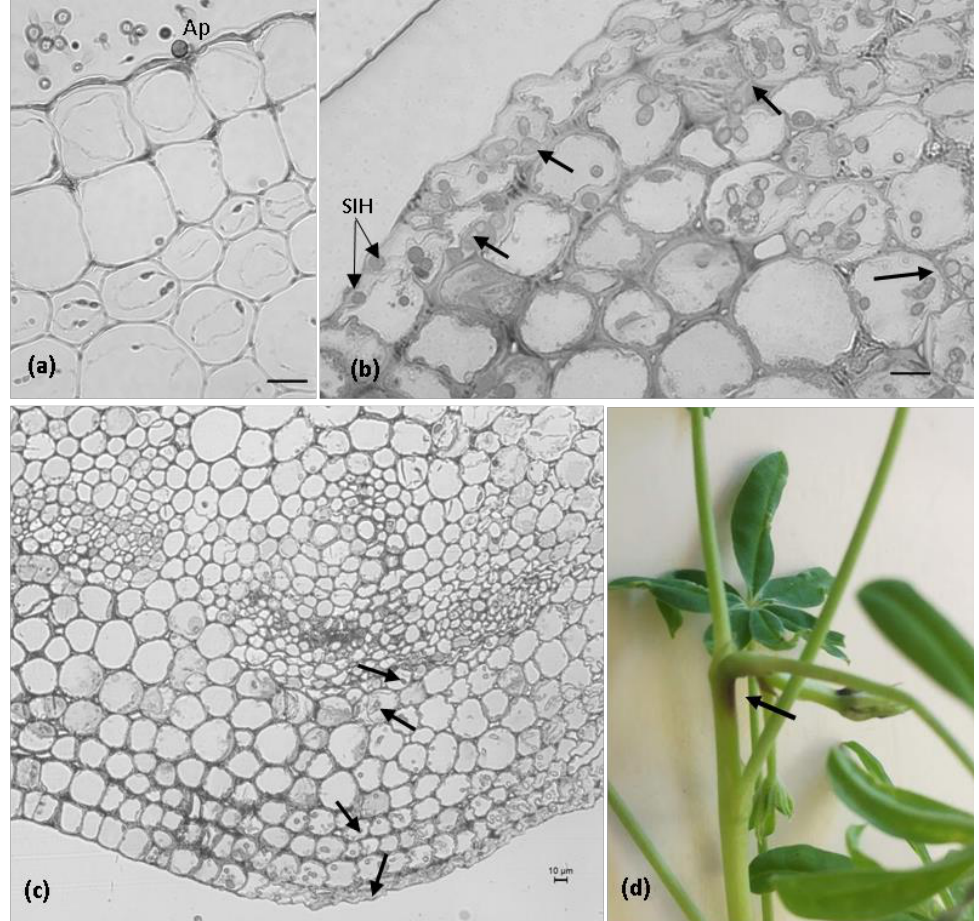
Figure 6. The Colletotrichum lupini infection process on the stems of Lupinus mutabilis and the macroscopic symptoms. ( a – c ). Light microscopic observation, toluidine blue staining. ( a ). Infection site showing a melanized appressorium (Ap) 3 days after inoculation (dai). ( b ). Infection sites showing subcuticular intramural hyphae (SIH) and hyphae developing intra- and intercellularly (arrows) in epidermal and cortex host cells 6 dai. ( c ). Fungal colonization extended from the cuticle and epidermal cells to the vascular system (arrows). Note the intense degradation and deformation of epidermal and cortex plant cells 9 dai. ( d ) Stem with dark sunken lesions (arrow) 9 dai. Scale bar = 10 µ m. A diagram of the infection process that is used by Colletotrichum lupini to colonize Lupinus mutabillis petioles and stems is represented in Figure